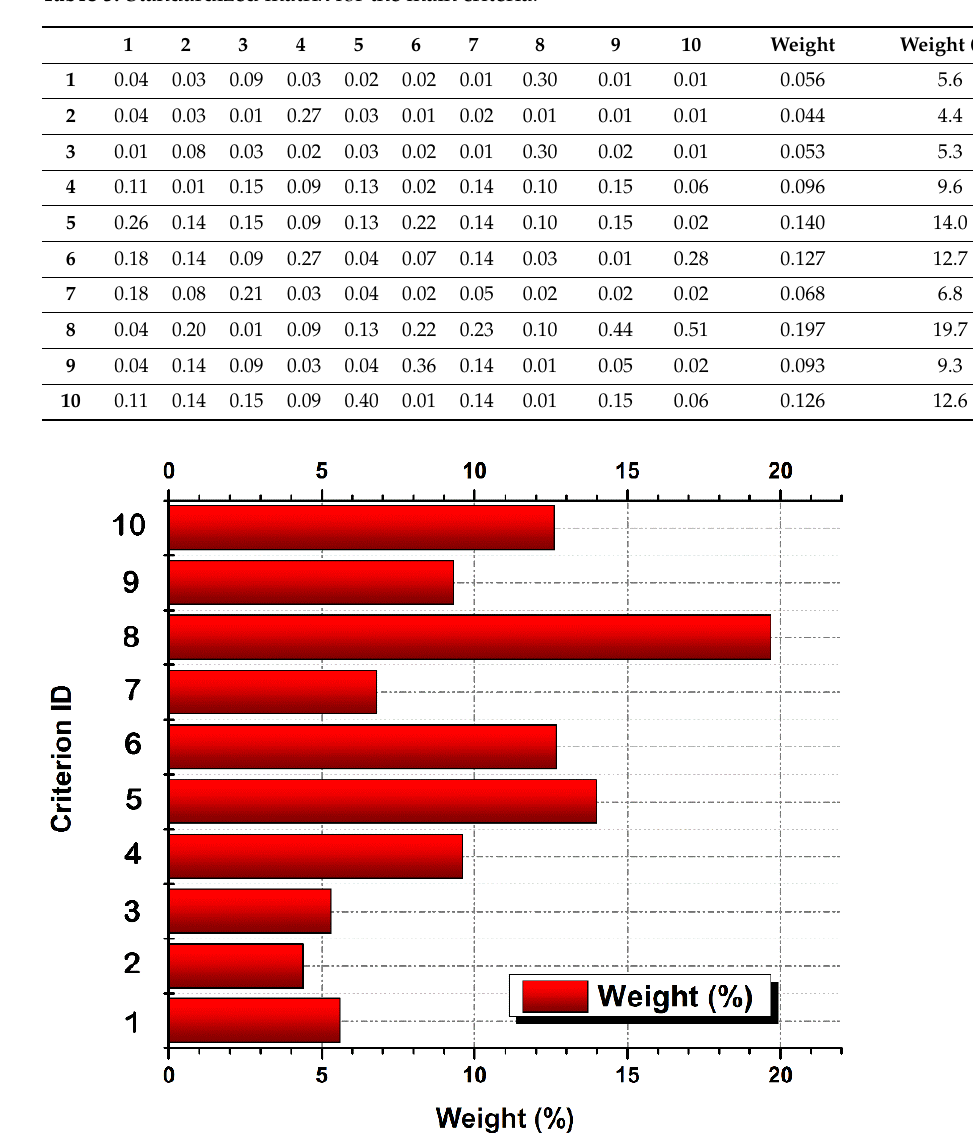
Figure 6. Weight of the percentage for each criterion used for GI suitability.